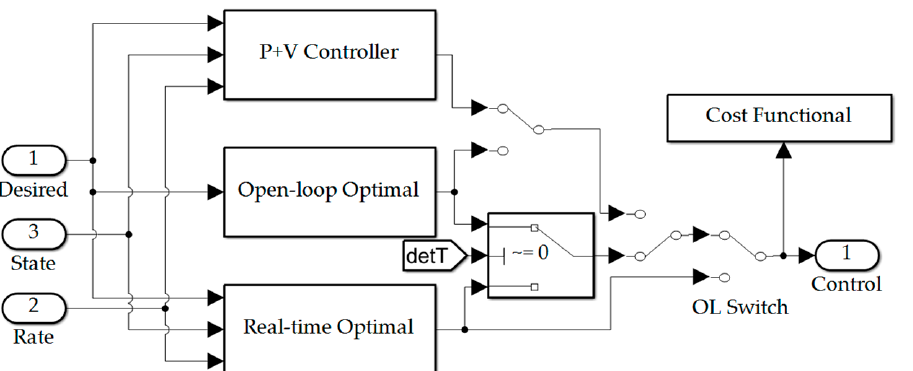
Figure A3. Controllers’ simulation topology.